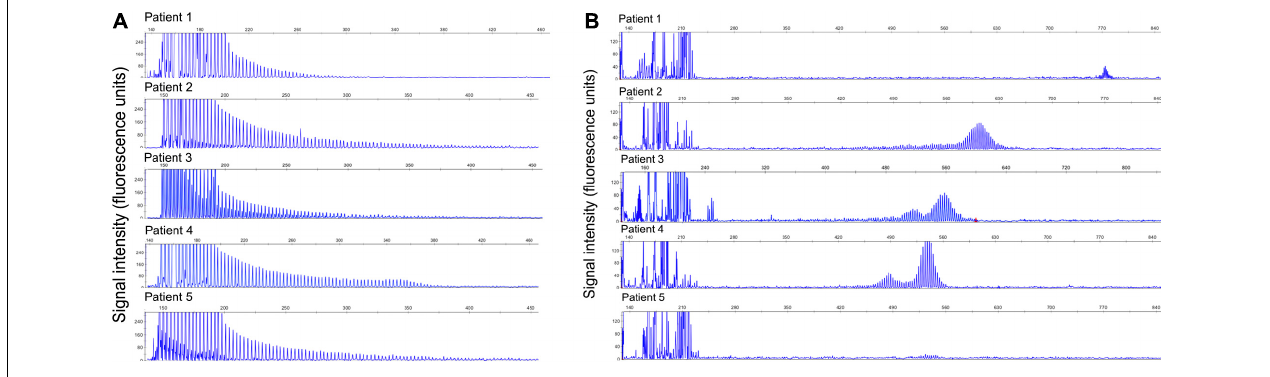
FIGURE 1 | Validation of GGC repeat expansions and repeat lengths in the NOTCH2NLC gene. (A) Validation of GGC repeat expansions in the NOTCH2NLC gene among five index patients by RP-PCR. (B) Validation of repeat lengths of GGC repeats in the NOTCH2NLC gene among five index patients by